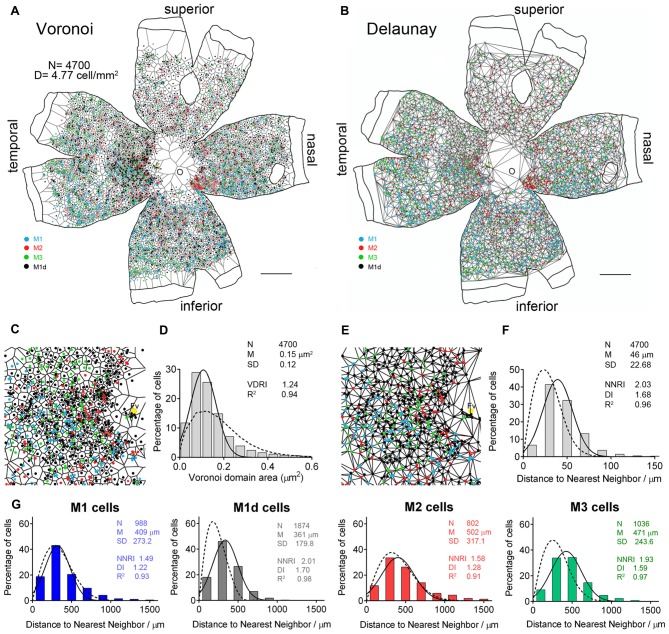
Distribution pattern of human mRGCs. (A) Voronoi tessellation associated with the mRGC mosaic of a 56-year-old whole human retina. (B) Delaunay tessellation associated with the mRGC whole retina mosaic, as well as the set of Delaunay segments for single cells, the shortest of which is the distance of the nearest neighbor to each cell. (C) Higher magnification image of Voronoi tessellation. (D) Frequency distribution associated with the Voronoi domains, showing the regularity index (VDRI). (E) Higher magnification image of Delaunay tessellation close to the fovea area (Fv). (F) Frequency distribution of the nearest neighbor densities of mRGCs, independently of the cell type, showing the nearest neighbor regularity index (NNRI) and dispersion index (DI). The solid line represents the Gaussian function fitting the data. The Voronoi (D) and Delaunay (F) analysis of a random pattern with the same density and SD is also shown for the purposes of comparison (dotted line). (G) Frequency distribution of NND for the different types of mRGCs in the whole-mount retina showed in (A,B). N, number of cells; M, mean value (area or distance); SD, standard deviation; R2, R-squared value. Scale bar: 5 mm.